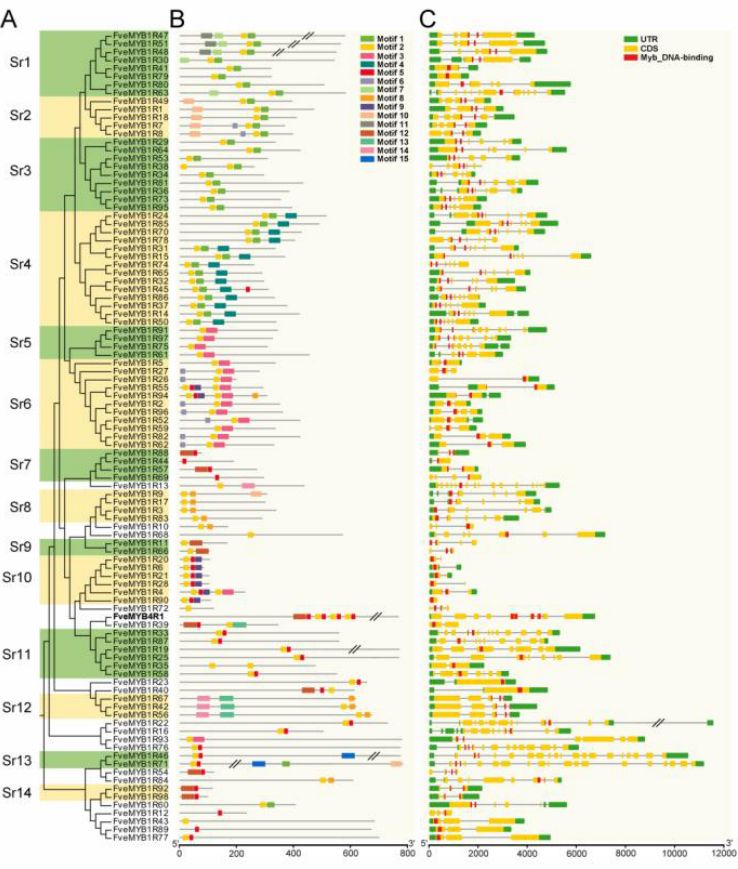
Figure 2. The phylogenetic relationship, conserved motif structure, domain, and intron – exon organization of 1R-MYB and 4R-MYB proteins in woodland strawberry. ( A ) Phylogenetic tree of 98 1R-MYB proteins and one 4R-MYB protein in woodland strawberry. According to previous study in soybean [26], the phylogenetic tree was divided into 14 subgroups (Sr1 – Sr14) based on bootstrap values (>50). Some proteins were not clustered together due to bootstrap values were below than 50. ( B ) The motif composition of 1R-MYB and 4R-MYB proteins from woodland strawberry. Fifteen motifs are marked with different color boxes. ( C ) The domain composition and intron – exon organization of 1R-MYB and 4R-MYB proteins from woodland strawberry. Red boxes represent Myb_DNA-binding domains. The exon structure was shown as yellow CDS (s) and green UTR (s). The space (grey lines) between the boxes were intron(s).